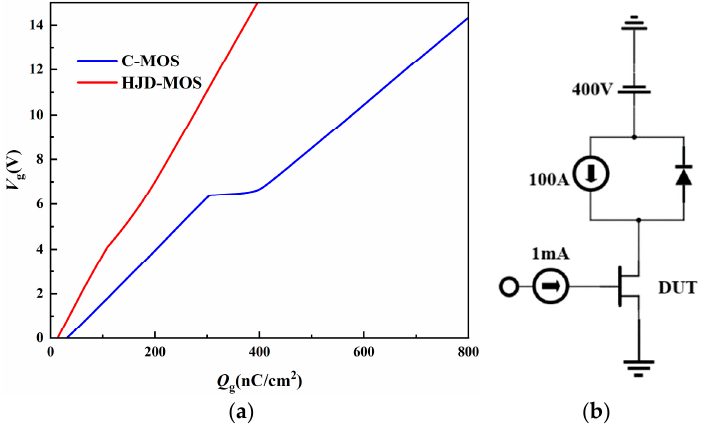
Figure 9. ( a ) The gate charge of the C-MOS and the proposed structure. ( b ) The test circuit of the gate charge.